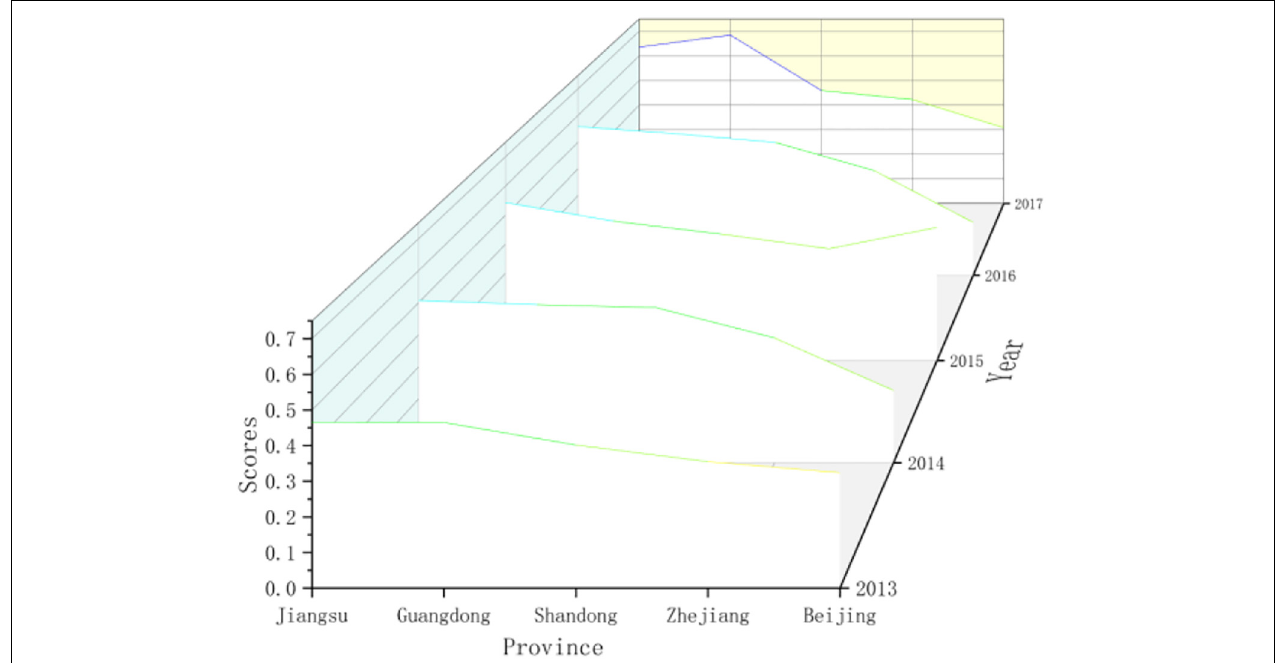
FIGURE 2 | Comparing the scores of the sports development resilience driving force subsystem in some regionals in China.